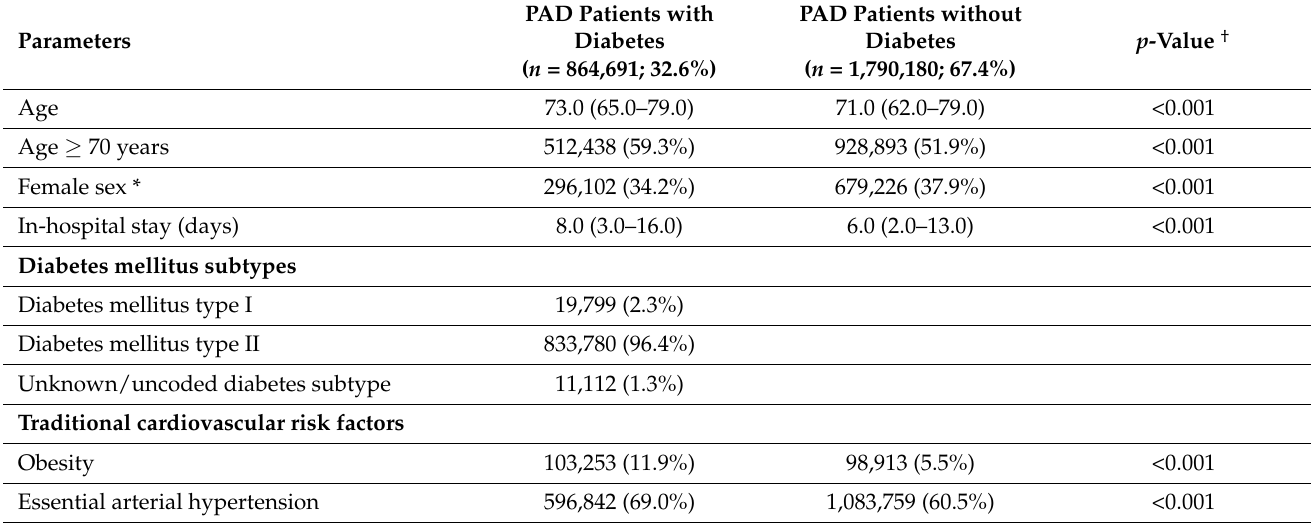
Table 1. Patients’ characteristics, medical history, presentation and outcome of the included 2,654,871 PAD patients stratified according to the presence of diabetes